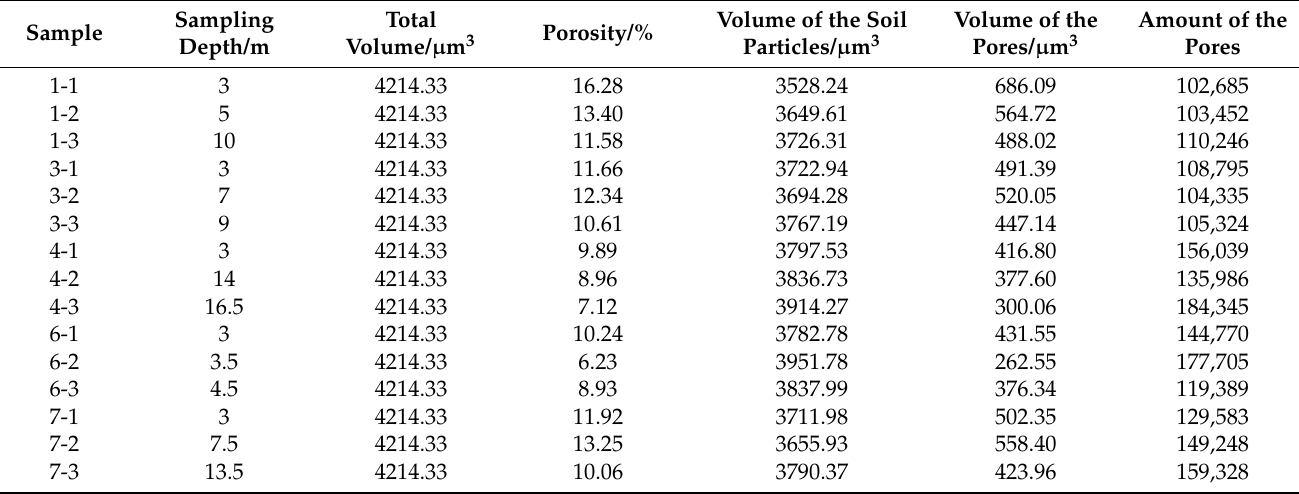
Table 2. The pore characteristics of all the